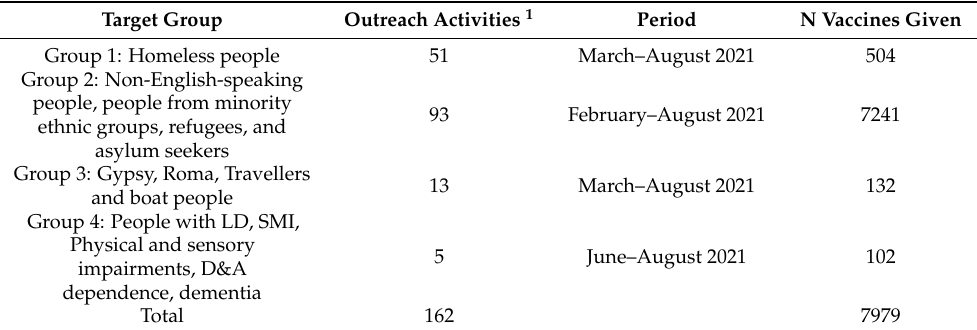
Table 1. Number of outreach activities and COVID-19 vaccines given (including first and second doses) for each of the MUG target